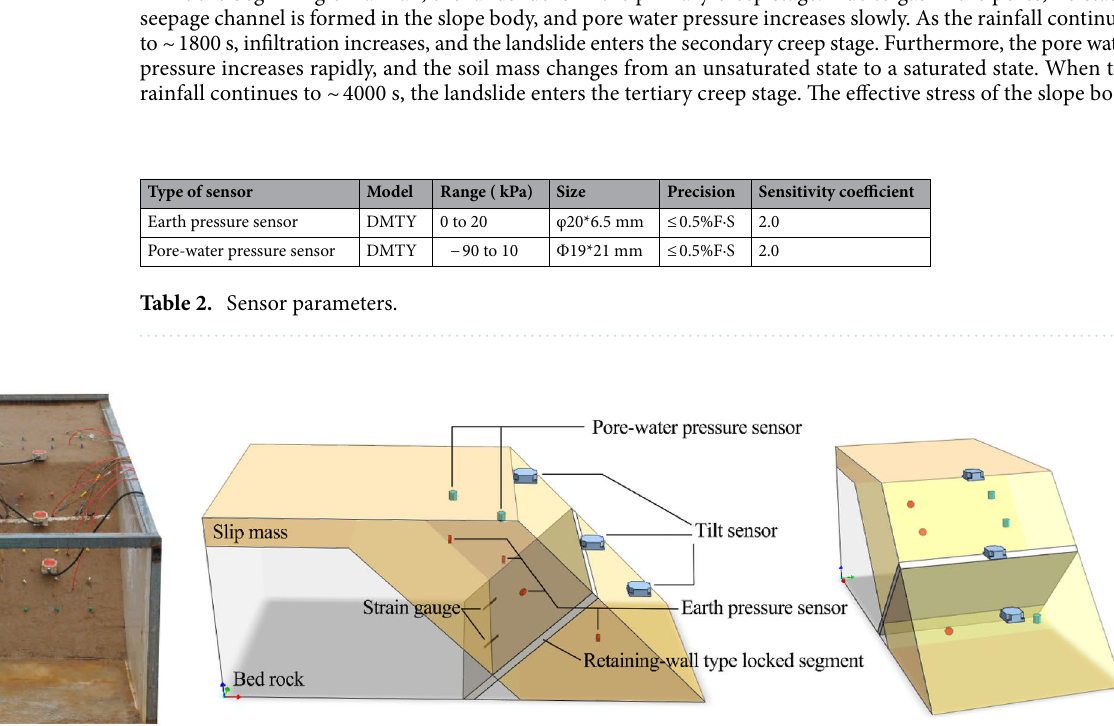
Figure 1. Landslide model and instruments